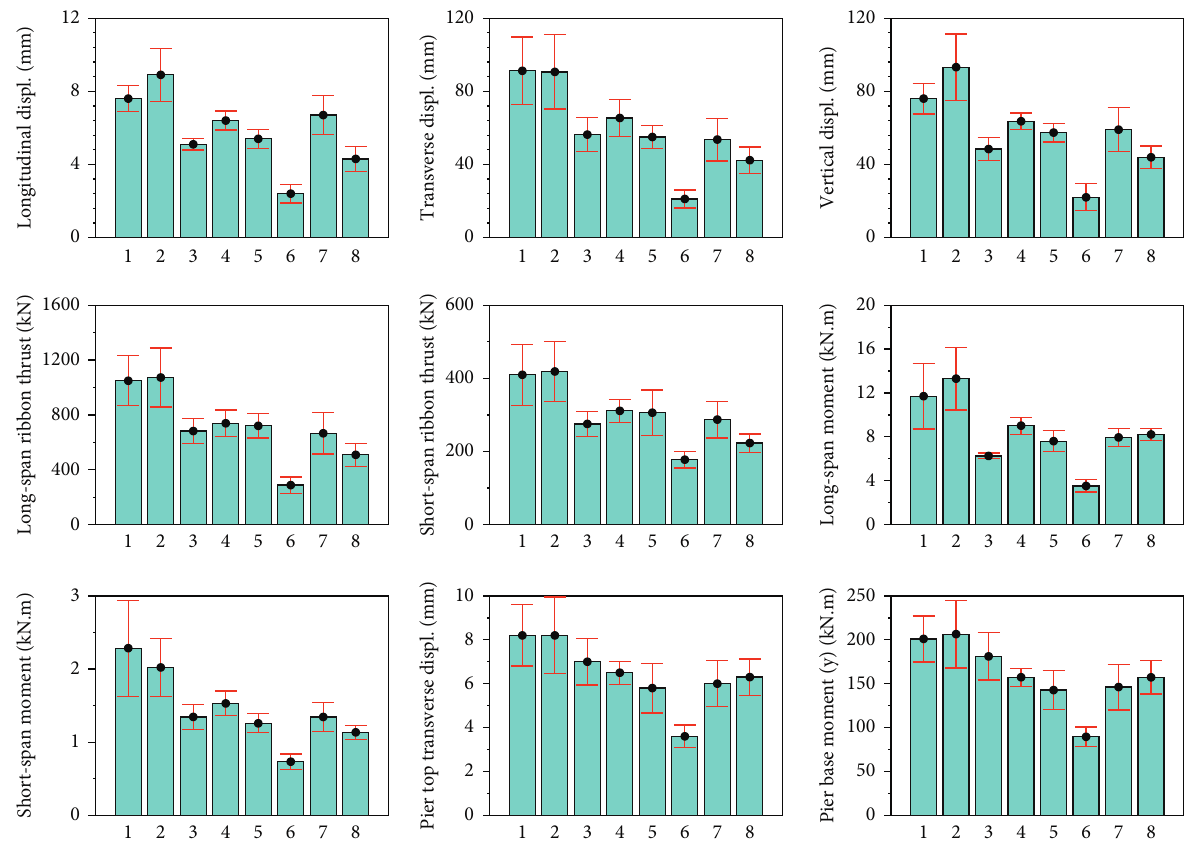
Figure 11: Variation of various responses resulting from different